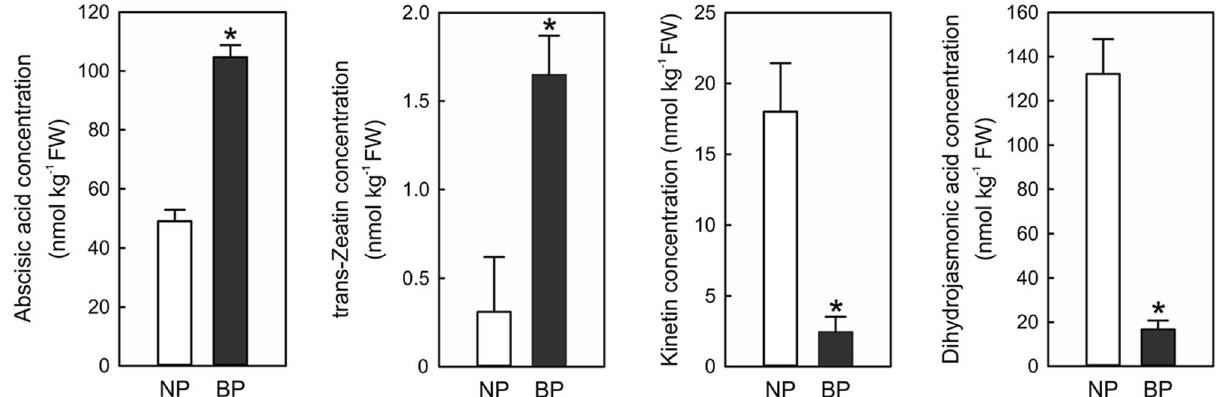
Figure 6. Endogenous hormonal levels change of A. sinensis between BP and NP before